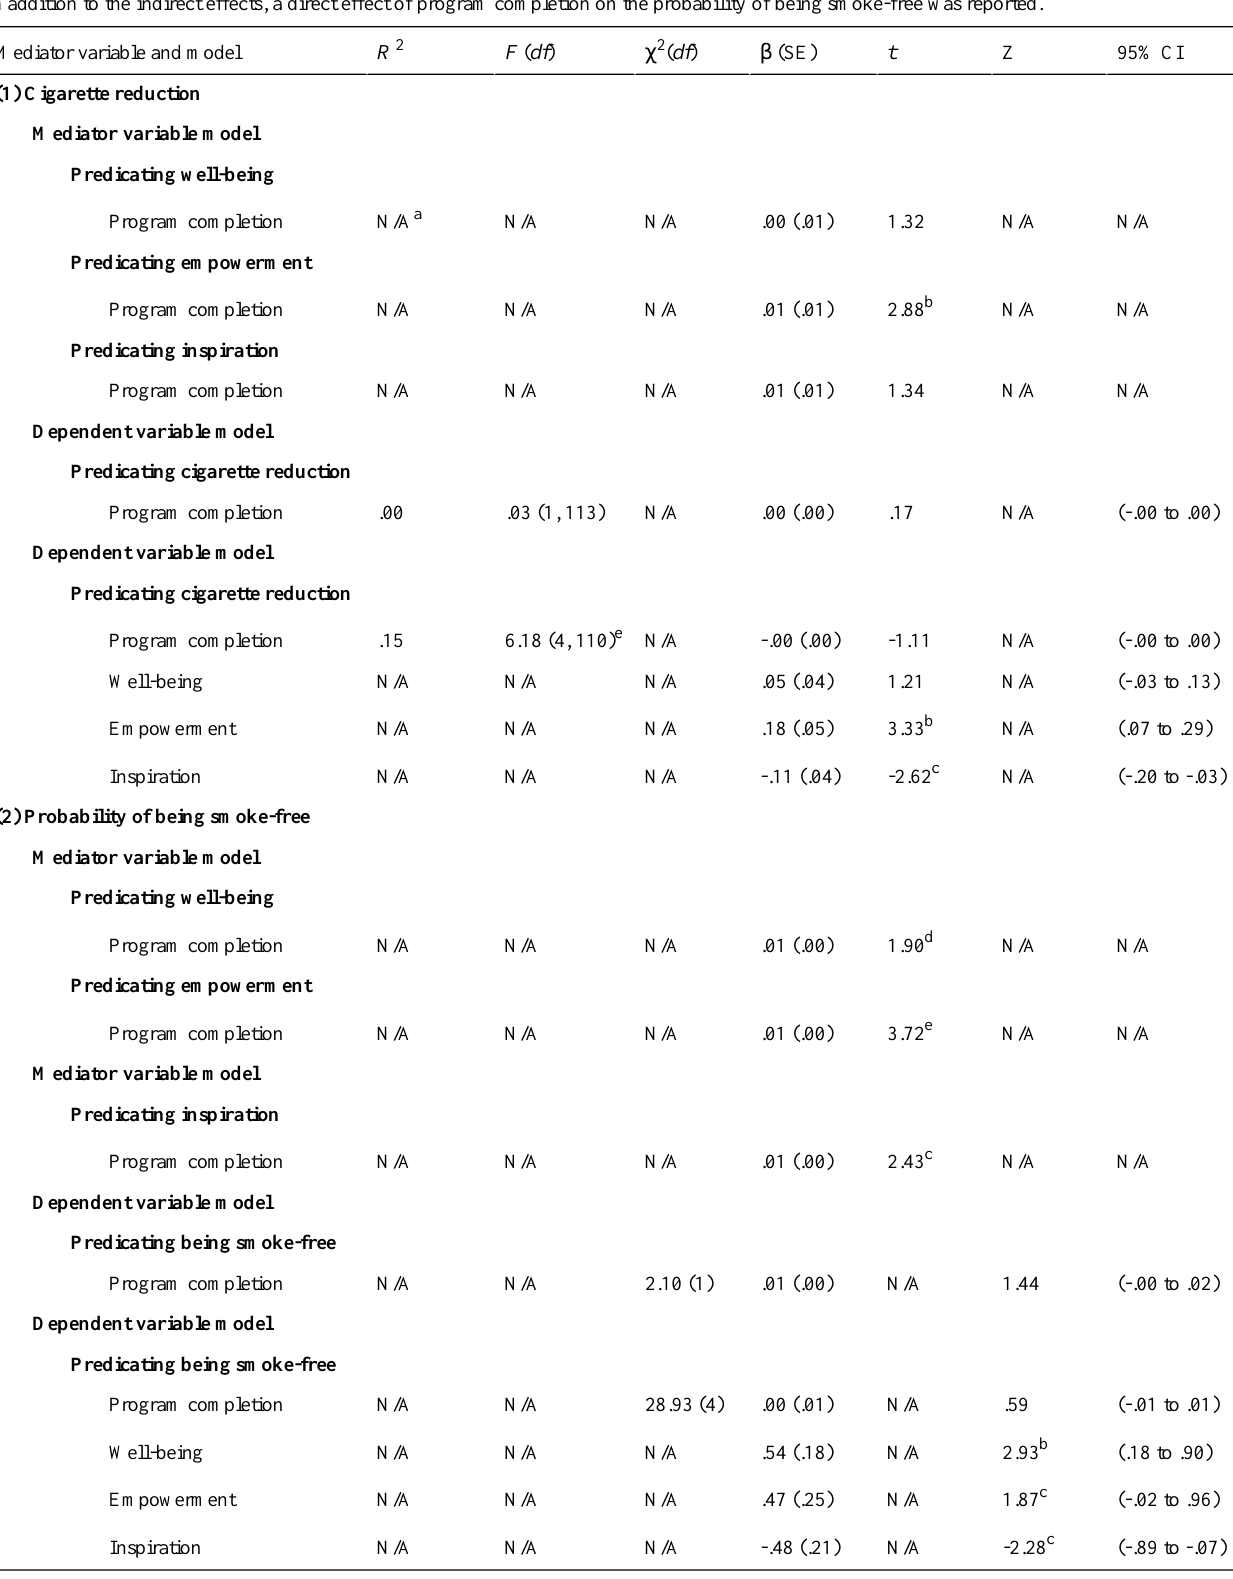
Table 6. Mediation test results. Model 1 tests the mediational role of well-being, empowerment, and inspiration as mediating the relationship between program completion (as independent variable) and number of cigarette reduction per day (as dependent variable). In addition to the indirect effects, a direct effect of program completion on cigarette reduction was reported. Model 2 tests the mediational role of well-being, empowerment, and inspiration as mediating the relationship between program completion (as independent variable) and the probability of being smoke-free (as dependent variable). In addition to the indirect effects, a direct effect of program completion on the probability of being smoke-free was